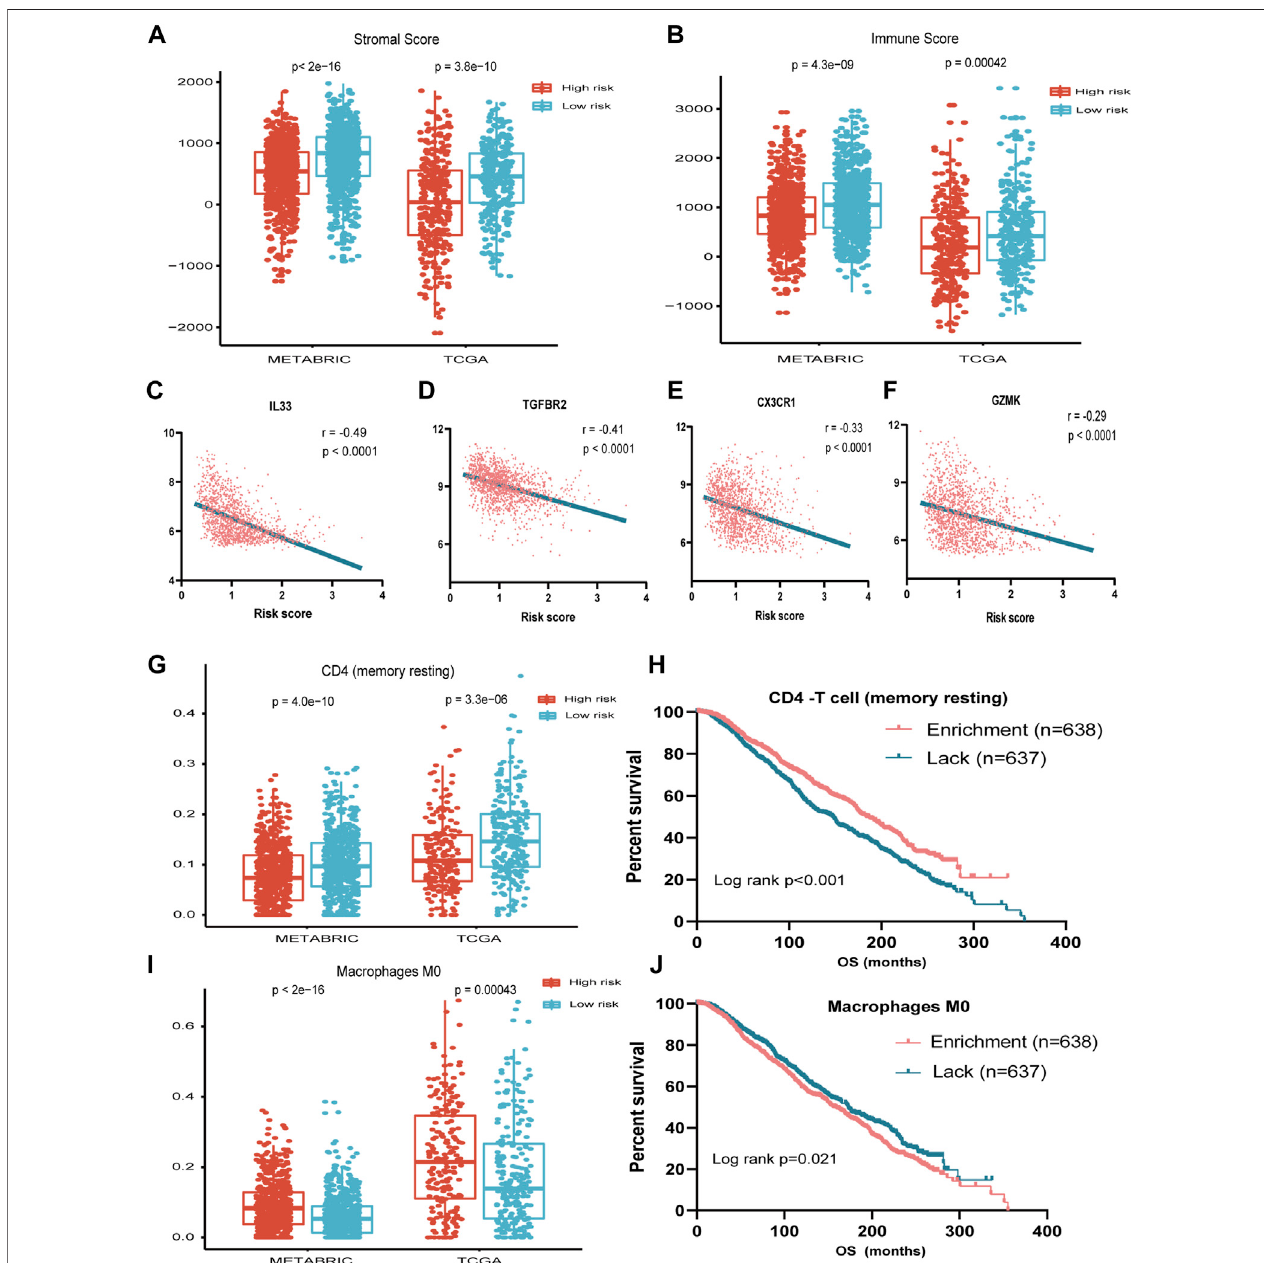
FIGURE4| Associationbetweenseven-immune-related-geneIRSandTME. (A) AssociationbetweenIRSandstromalscoreinMETABRICandTCGAcohorts. (B) AssociationbetweenIRSandimmunescoreinMETABRICandTCGAcohorts. (C) AssociationbetweenIRSandIL33inTCGAcohort. (D) AssociationbetweenIRSand TGFBR2inTCGAcohort. (E) AssociationbetweenIRSandCX3CR1inTCGAcohort. (F) AssociationbetweenIRSandGZMKinTCGAcohort. (G) Associationbetween IRSand restingmemory CD4 + TcellsinMETABRIC andTCGA cohorts. (H) OSforpatients withhighor lowresting memoryCD4 + TcellsintheMETABRIC cohort. (I) AssociationbetweenIRSandM0cellscoreinMETABRICandTCGAcohorts. (J) OSforpatientswithhighorlowmacrophageM0cellscoreintheMETABRICcohort. IRS: immune risk signature; TME: tumor microenvironment; METABRIC: Molecular Taxonomy of Breast Cancer International Consortium; TCGA: The Cancer Genome Atlas; OS: overall survival; ***: p < 0.001; ****: p < 0.0001.